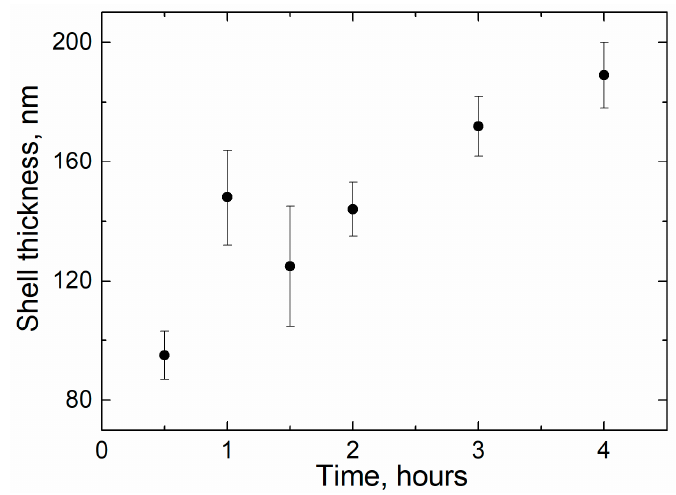
Figure 5. SiO 2 shell thickness vs. hydrolysis duration, “time”.